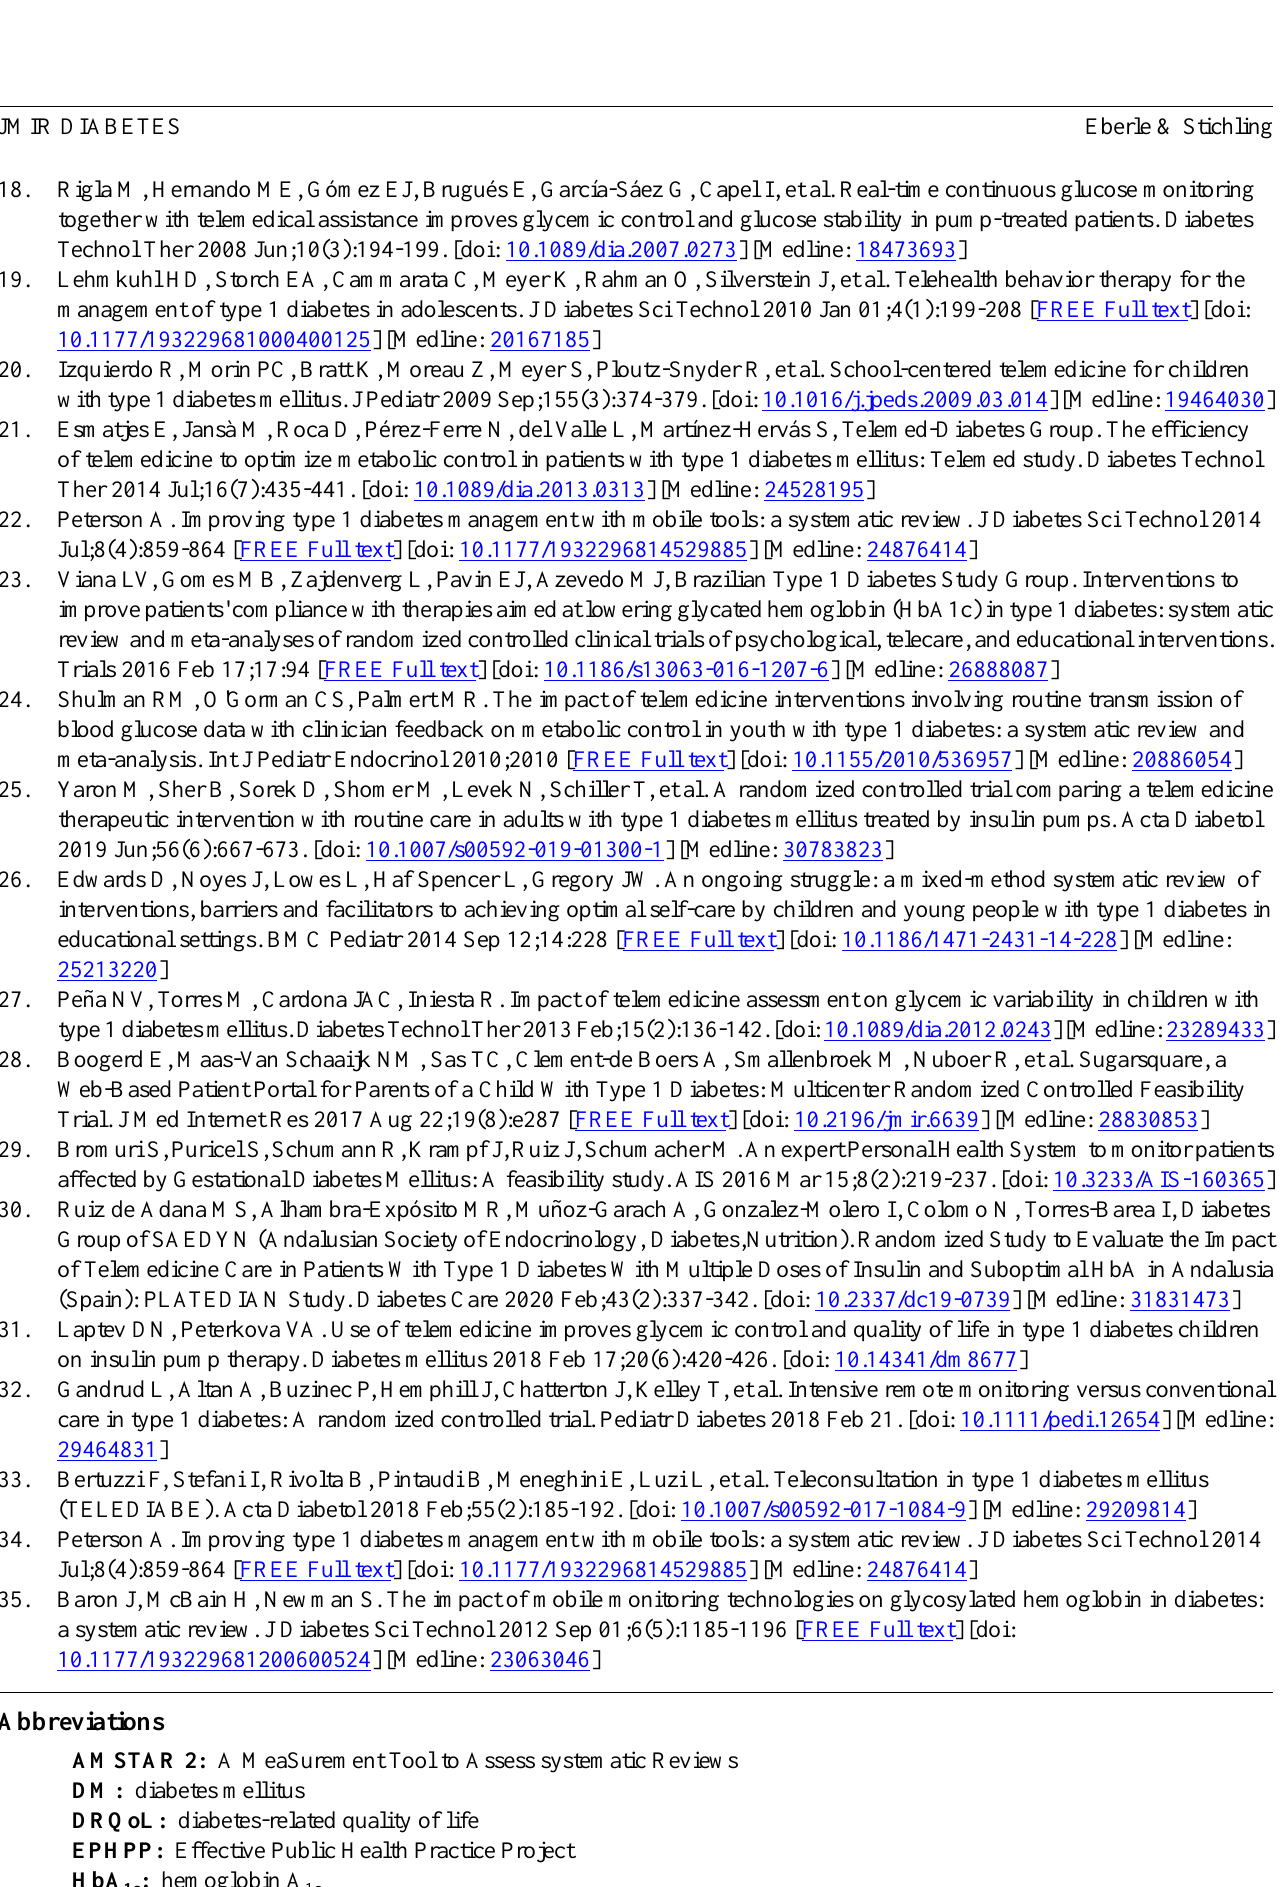
EPHPP: Effective Public Health Practice